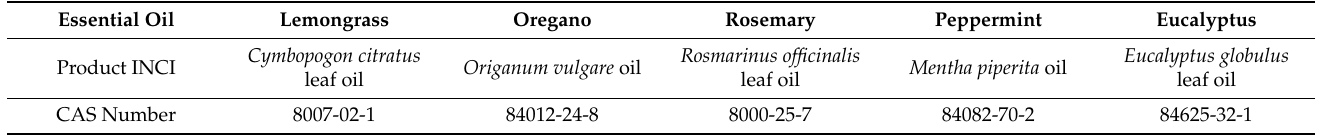
Table 9. Product specification of essential oils.